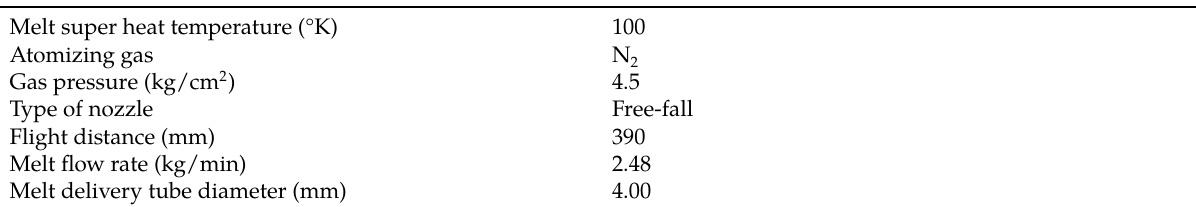
Table 2: Primary processing